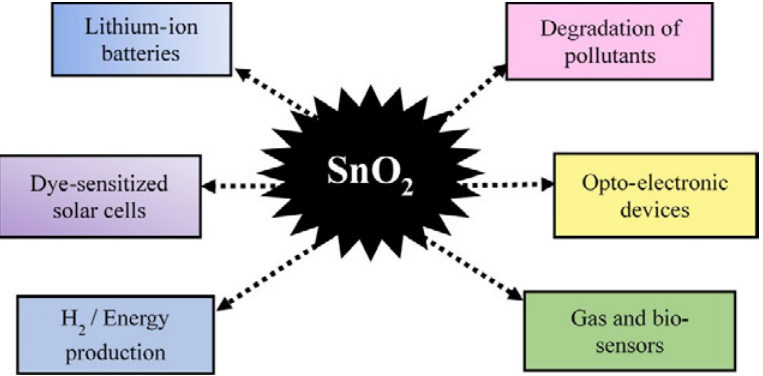
semiconductorFig 2. Versatile applications of Tin Oxide (SnO